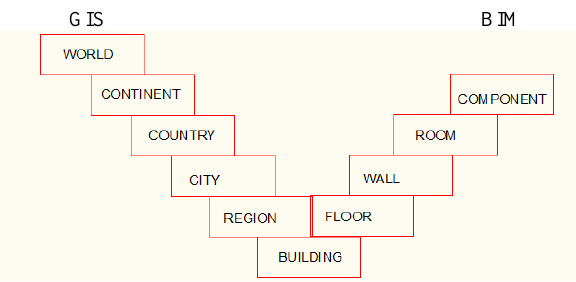
Figure. 1. Overlap between GIS and